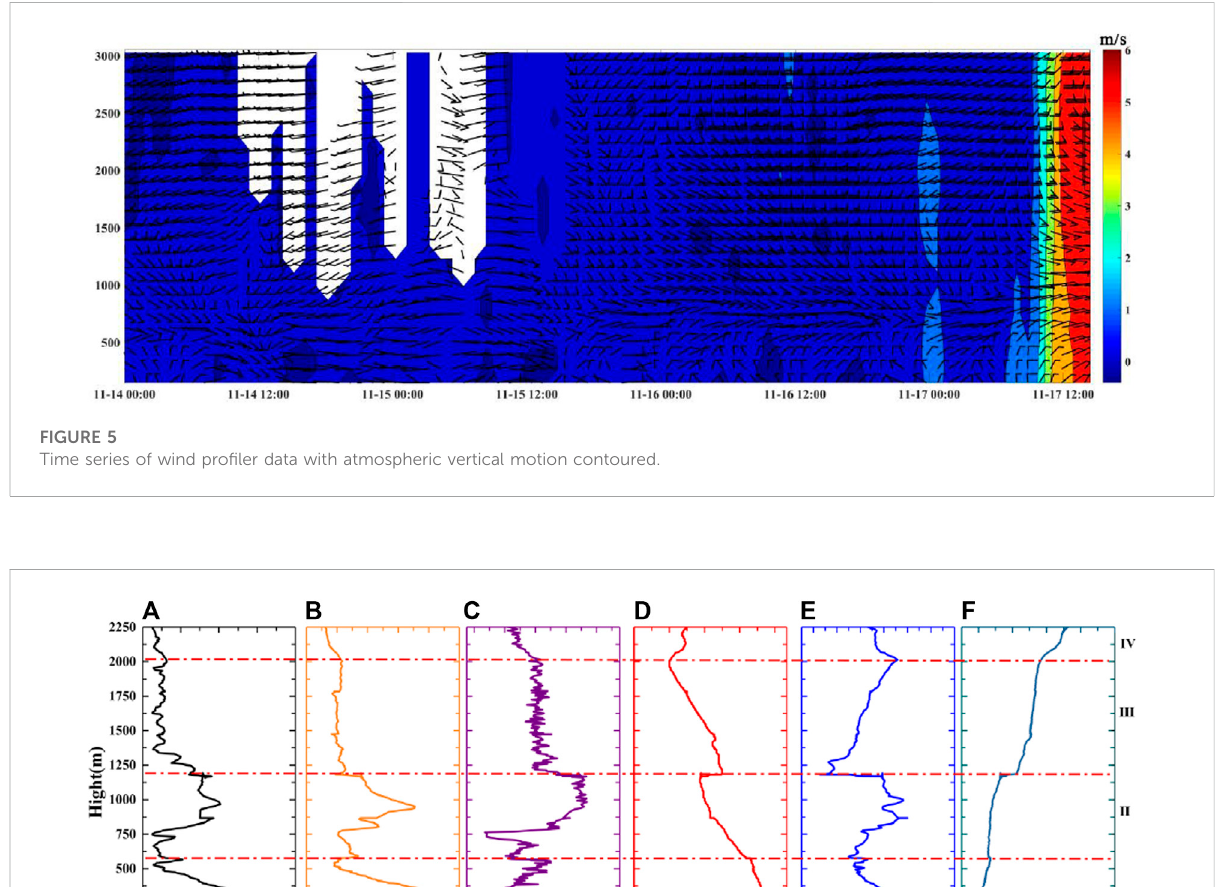
mean particle diameter was around 0.2 – 0.225 μ m. Near the ground, accumulated particles were mostly small particles. As 5438.416#/L. The mean diameter decreased from the top of